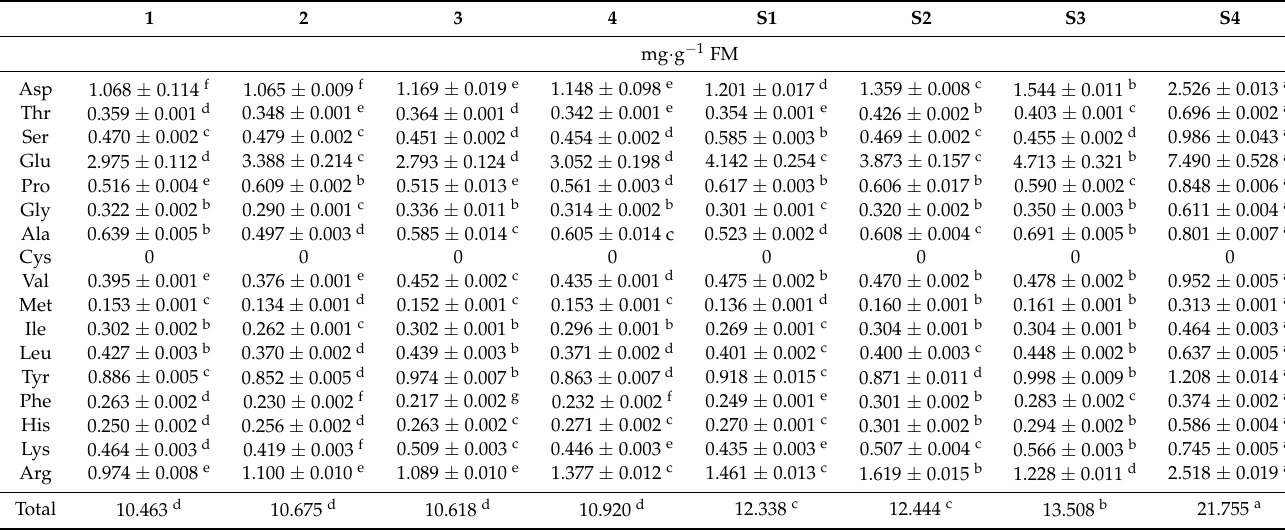
Table 3. Amino acid content of fresh and stored white cabbage with different forms of sulfur used as